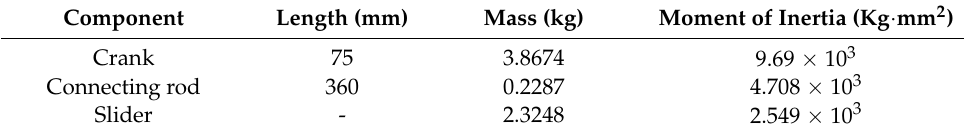
Table 1. Geometric and inertia properties of the slider-crank mechanism.